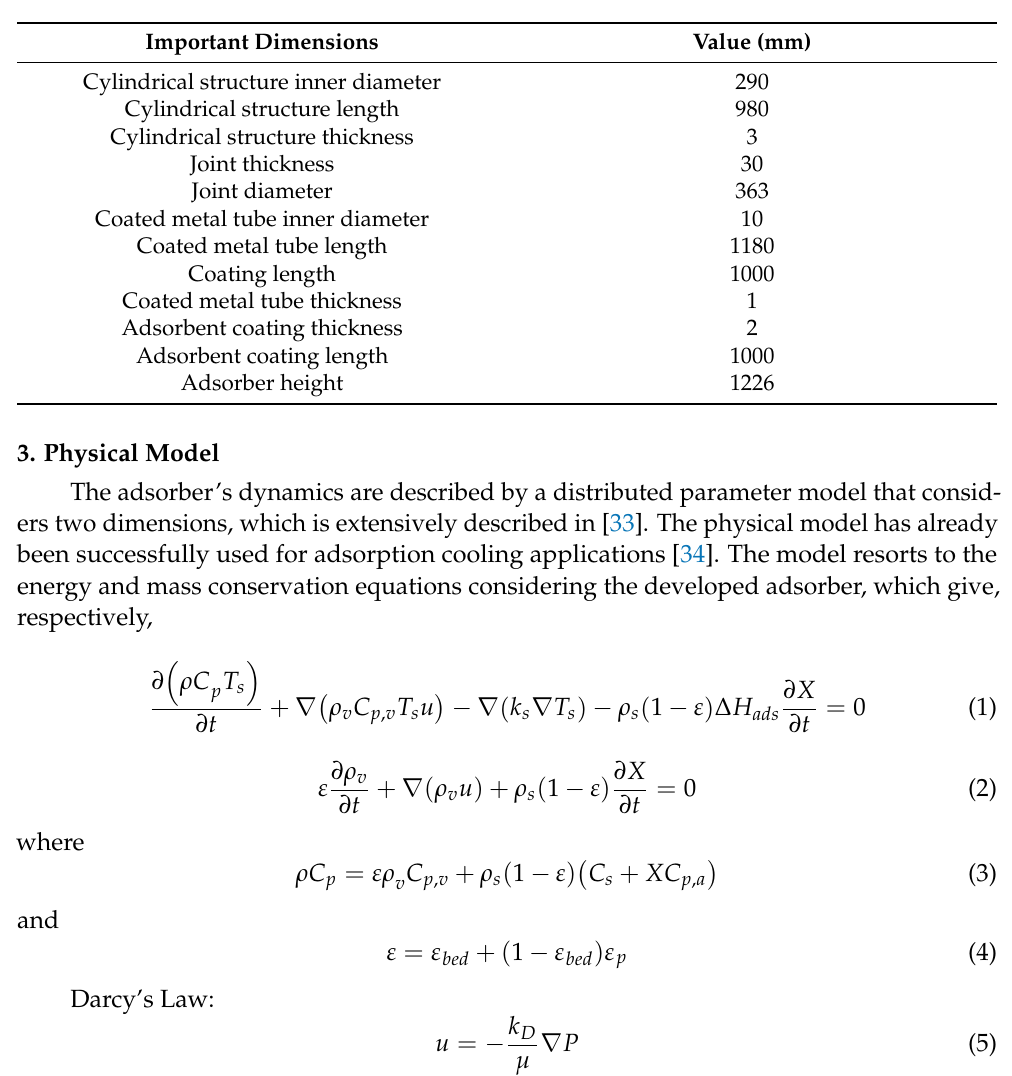
Table 1. Dimensions of the coated tube